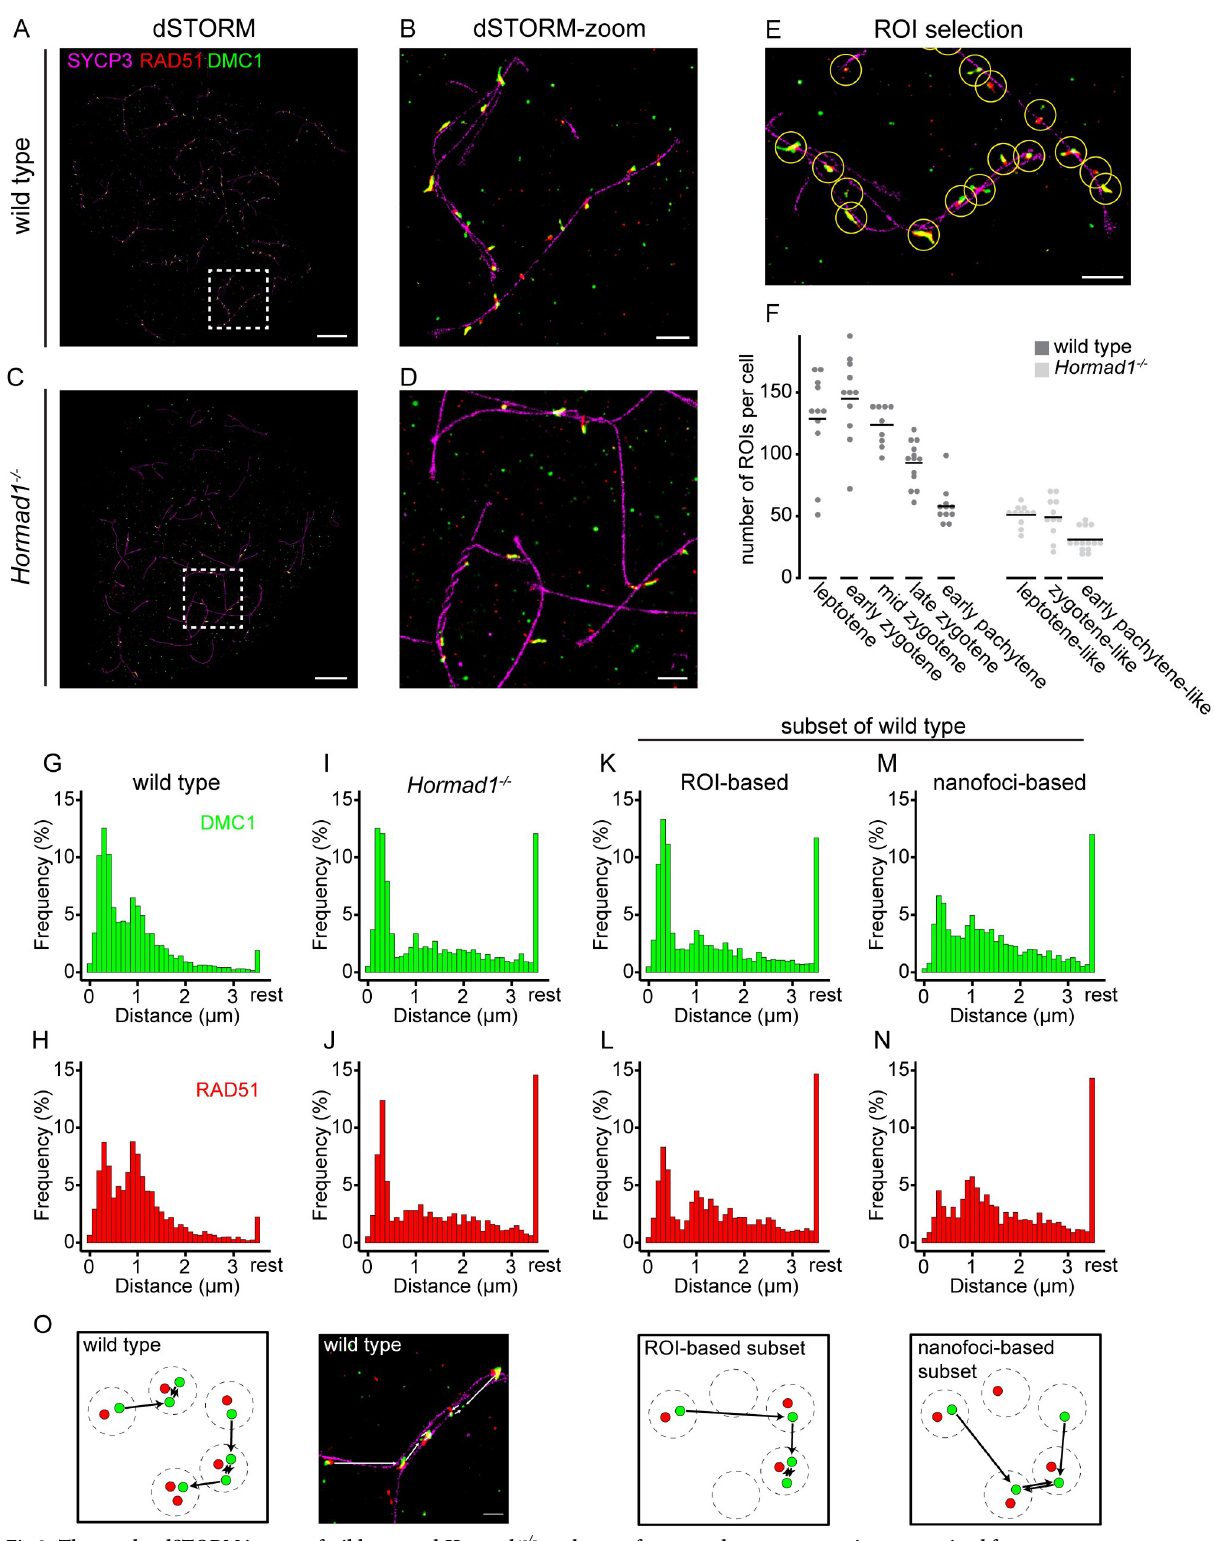
Fig 2. Three-color dSTORM images of wild type and Hormad1 -/- nuclear surface spread spermatocytes immunostained for SYCP3-RAD51-DMC1. A) dSTORM and B) close-up of boxed region shown in A) image of wild type mid-zygotene nucleus immunostained